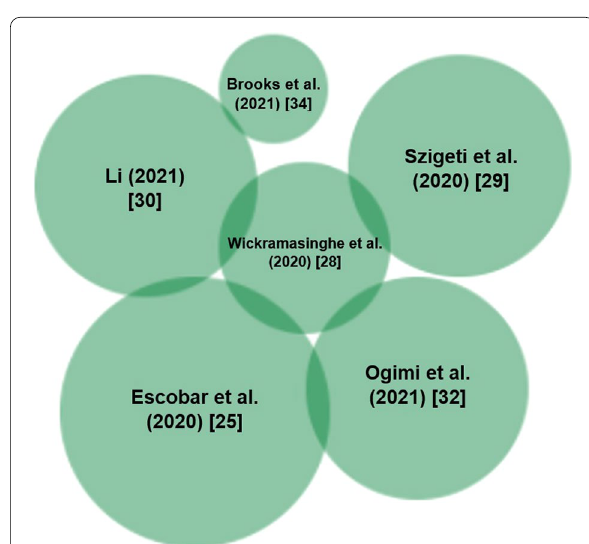
Fig. 3 Heat map of the magnitude of association between presence of national BCG Vaccination Policies and COVID-19